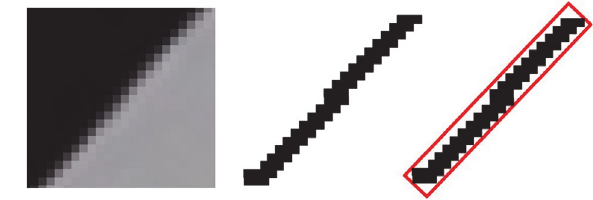
Figure 4: Line support